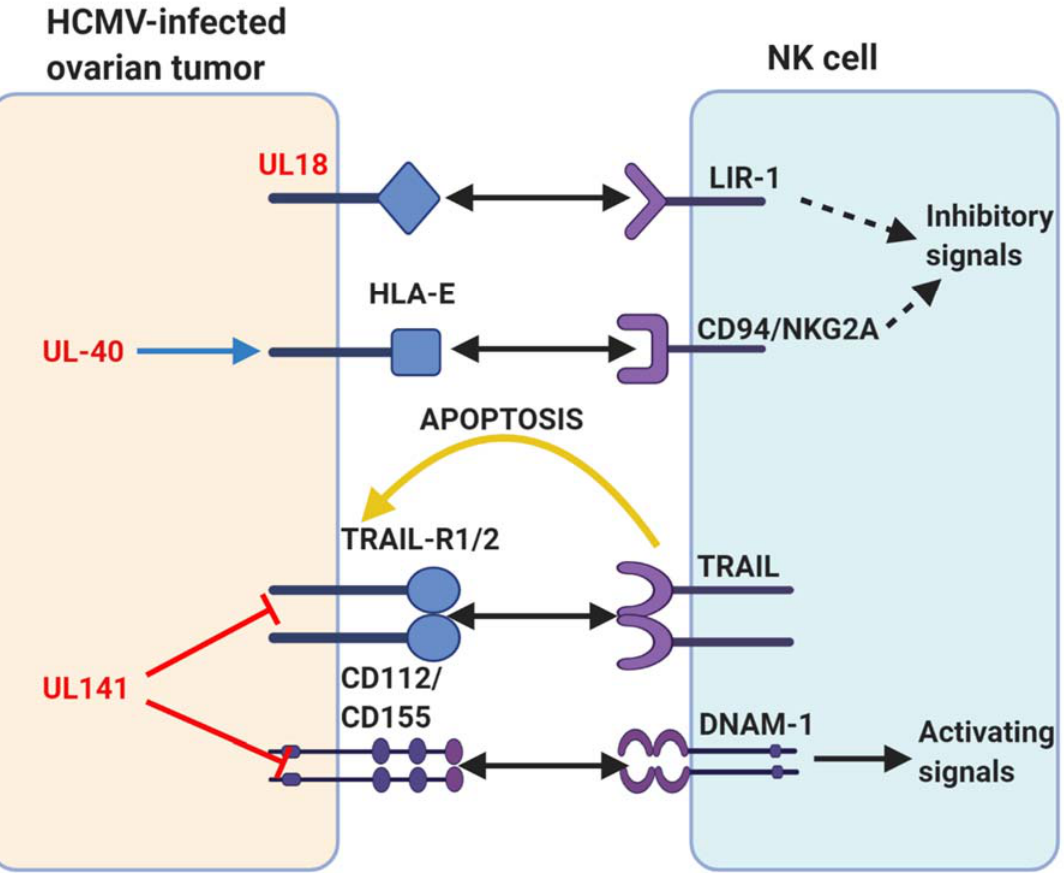
Figure 5. A summary of human cytomegalovirus (HCMV) modulation of natural killer (NK) cell cytotoxicity discussed in this review. Human proteins or receptors are labelled in black; HCMV proteins are labelled in red. The arrows represent actions. Two-pointed solid black arrow = interaction or ligation; one-pointed solid black arrow = intracellular NK cell activation signal; dotted black arrow = intracellular NK cell inhibition signal; yellow arrow = extracellular signal to target cell; red line = inhibits surface expression; blue arrow = increases surface expression. Figure created with BioRender.com.